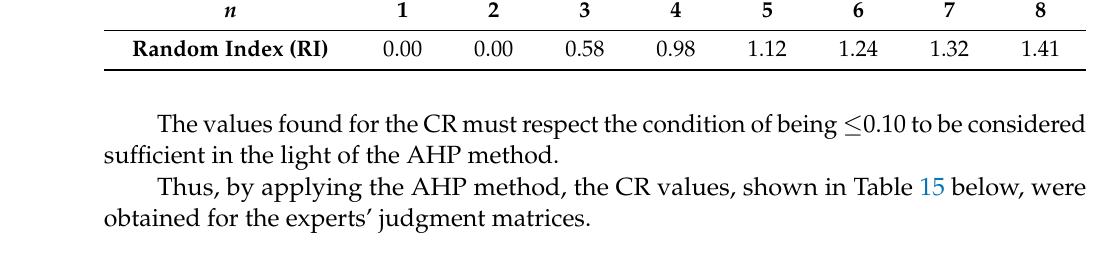
Table 15. Consistency analysis of the individual